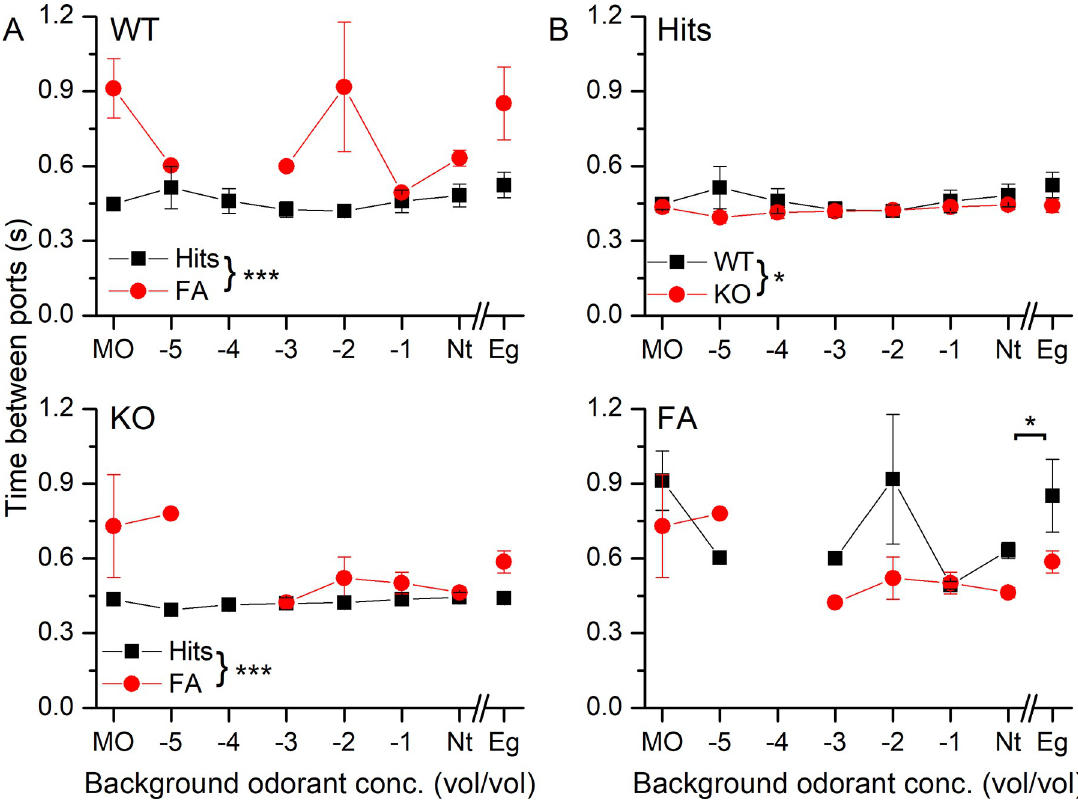
Fig 7. The odorant-dependent transition time between odor port and water port for WT and NCKX4 KO mice in the presence of background odorants. A The transition times for WT (top) and KO (bottom) mice between the odor and the water port following odorant sampling for Hits and FAs. B Comparison of Hits (top) and FAs (bottom) for WT and KO mice. The time between ports has as a final model a linear regression that has genotype (F = 5.7642, p = 0.02) and type (F = 24.0075, p = 5.843e -06 ) as significant effects. Tukey post-hoc analysis revealed that WT has a slower transition between the ports (p = 0.02) than KO. Also, overall, the time between ports is higher in the FA that in Hits (p = 1e -06 ). Repeated measures ANOVA showed that when considering transition times between ports in Nt vs Eugenol background odor trials there is a significant interaction between behavioral outcome and genotype (F = 7.13, p = 0.044) and behavioral outcome and background odor (F = 10.14, p = 0.024). Time between ports is different between Nt and Eg only for FAs (p = 0.046). Also, Eg FA is different from Nt (p = 0.006) and Eg for Hits (p = 0.001). Data points are averages ± SEM of 3 WT and 4 KO mice. The x-axis displays the log of the odorant concentration. Round brackets indicate differences across behavioral outcome or genotype, while scare brackets denote evaluation across concentration (or odor). Nt is neat propanol and Eg is neat